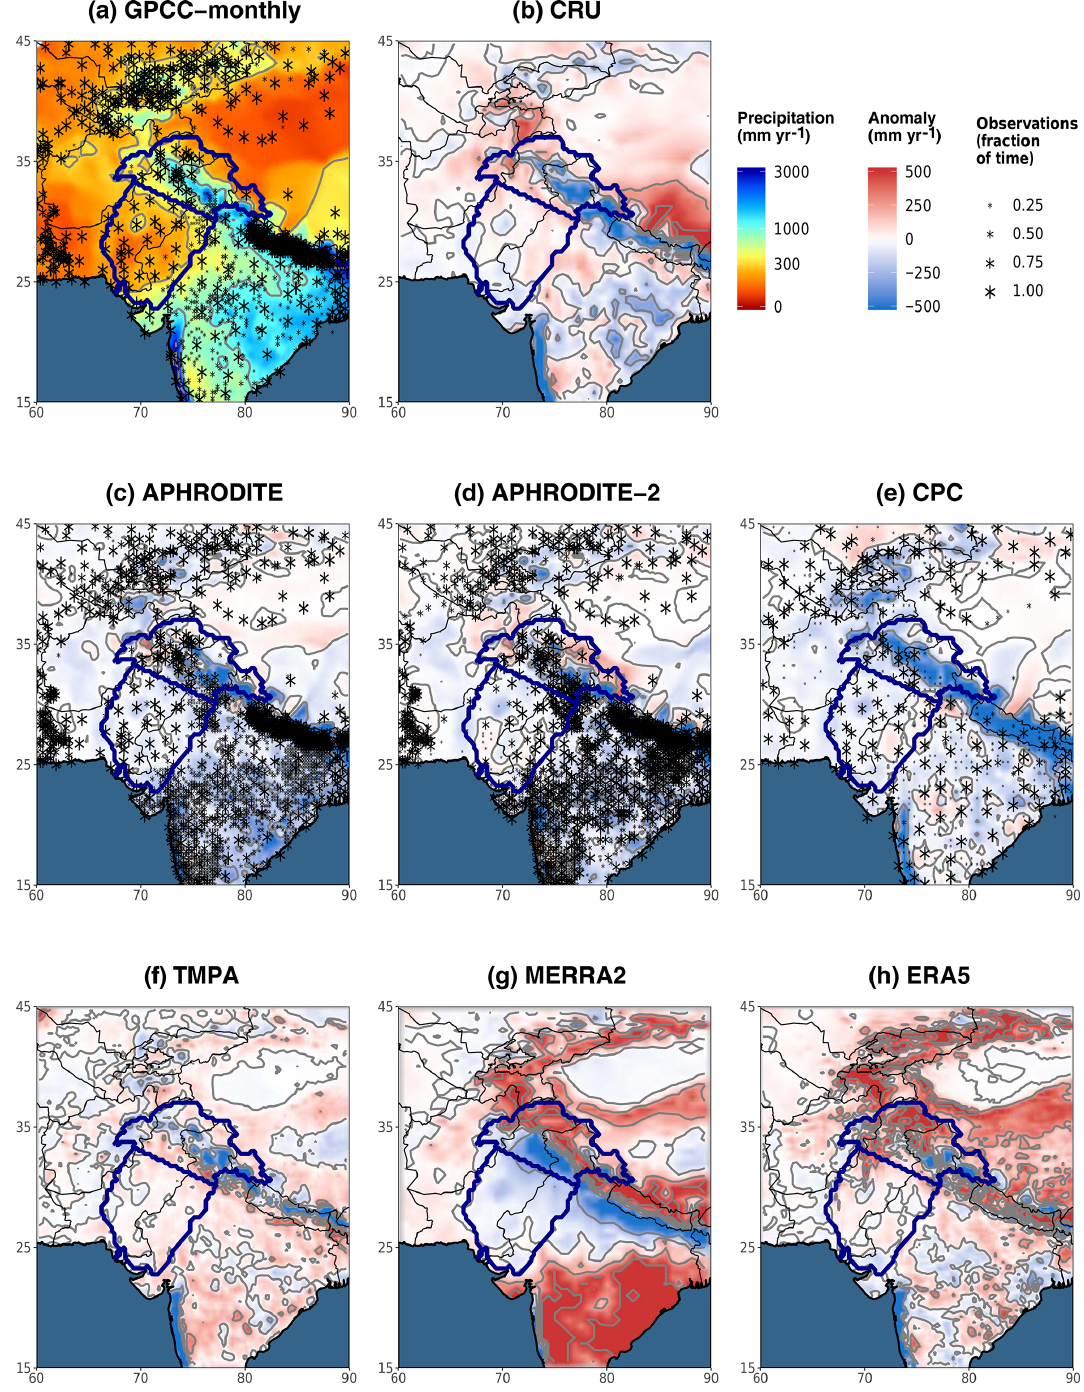
Figure 2. Map of annual mean precipitation for different datasets. The annual mean is computed over the period 1998–2007. GPCC monthly (a) is used as a reference to compute the anomaly for the other datasets (b–h) . The grey lines are the isohyets whose level cor- responds to the labels in the legend. The boundaries of the two study areas are displayed in dark blue on each map. The stars mark the grid cells that include at least one gauge observation. The size of the stars represents the number of time steps with at least one observation over that cell, relative to the total number of time steps needed to compute the annual mean (120 for a , 3652 for c, d , and e ). This information was not available for CRU (b) nor ERA5 (h) and does not apply to the satellite-based TMPA (f) and MERRA2 (g)